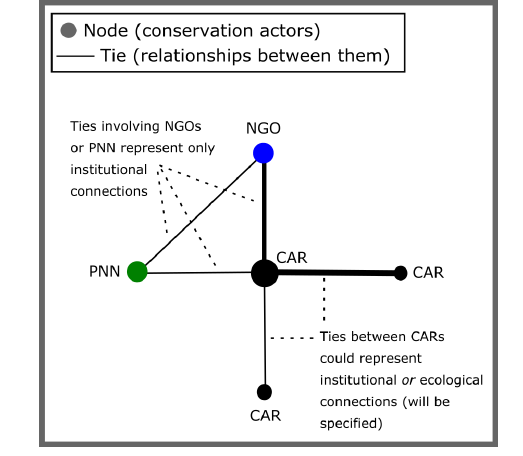
Fig. 1 . An example of a social network. Note the vast amount of information that can be portrayed; e.g., in this example, the ties between actors are of varying widths, indicating differing strengths of connections. The nodes themselves are sized according to the number of connections held by each; the middle autonomous regional corporation ( corporaciones autonomas regionales [CAR]) has four connections, the most in the network, and so is depicted with the largest circle (but sizes can also be indicative of other social network metrics). Nodes can also be color-coded to indicate different kinds of actors, as above, where green represents entities of Parques Nacionales Naturales (PNN), blue represents nongovernmental organizations (NGOs), and black represents the